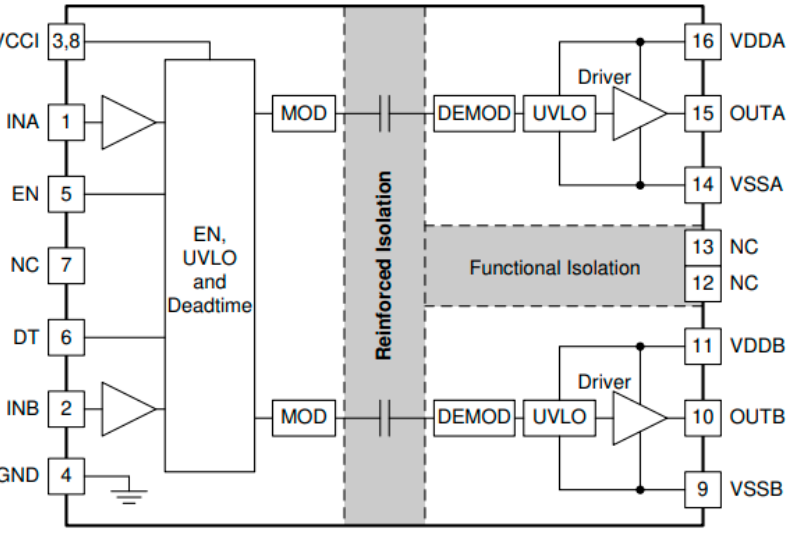
Figure 4. Functional block diagram of selected SiC transistor driver UCC21521 [20].